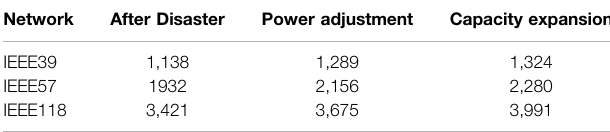
TABLE 2 | The values of LPS (MW) when the iterative greedy search scheme is applied to the bottleneck link in three IEEE tested cases.